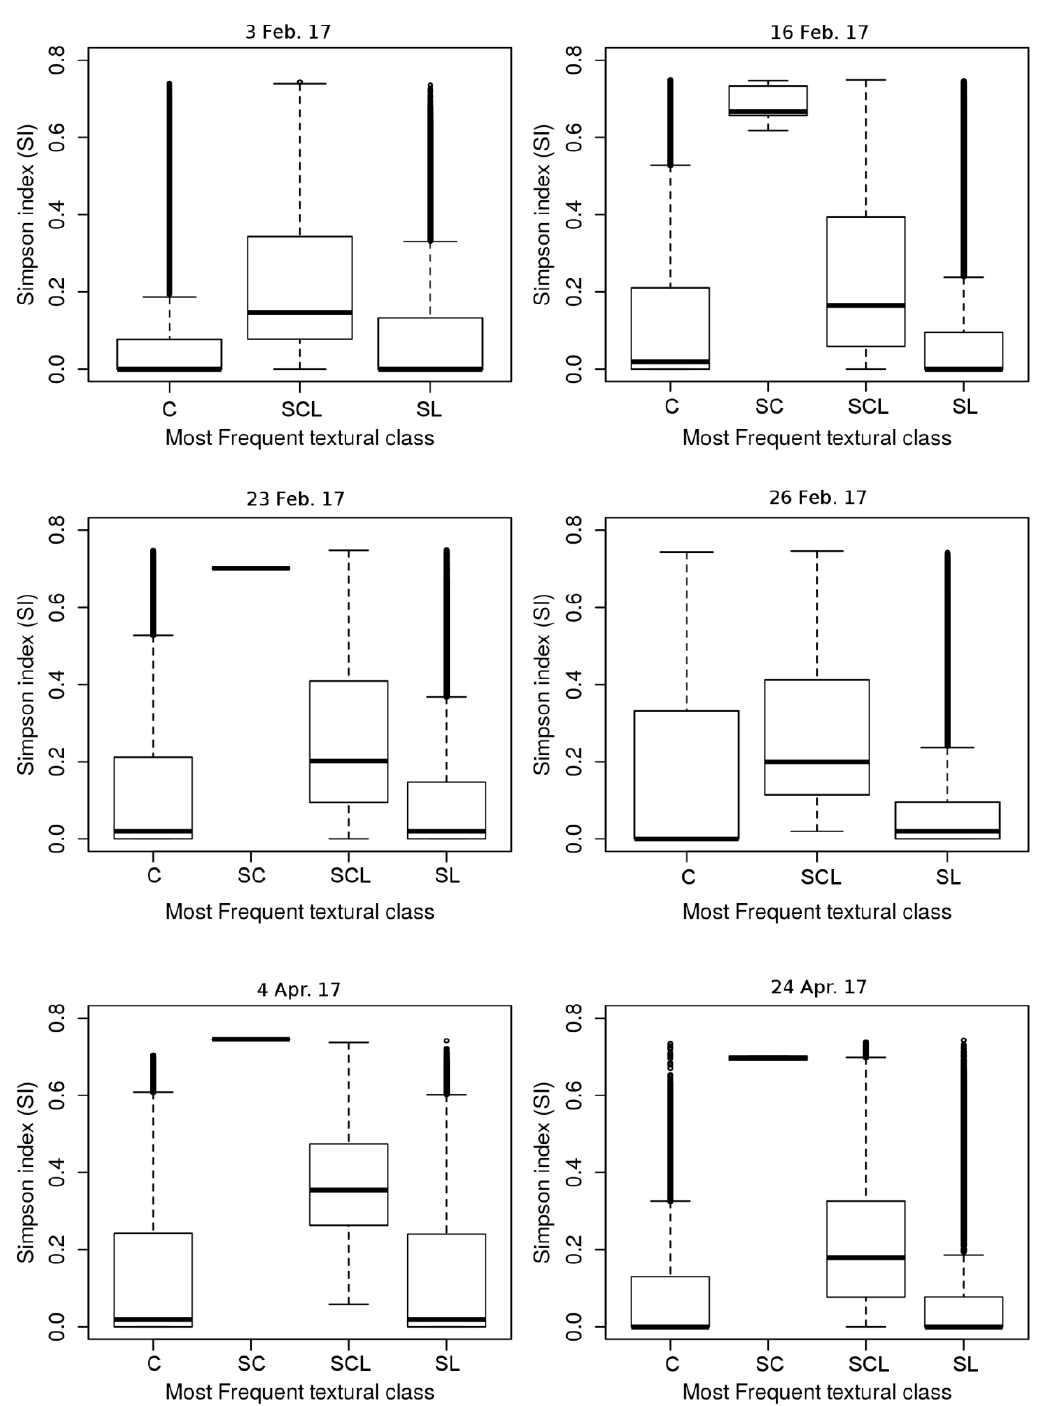
Figure 8. Boxplot of Simpson’s diversity index per class (the most frequent textural class in the set of 100 estimations) and per